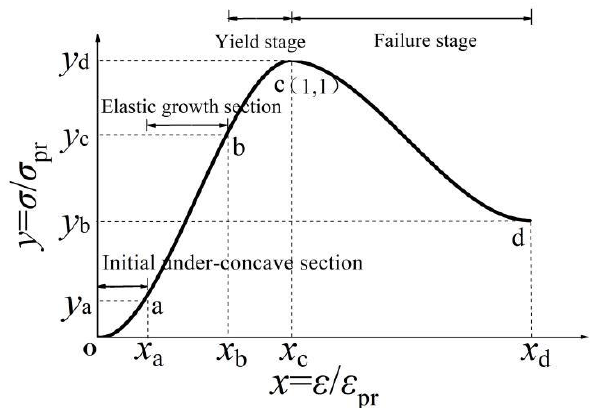
Figure 11. Typical curve of dimensionless stress-strain of earth materials under uniaxial compres- sion.